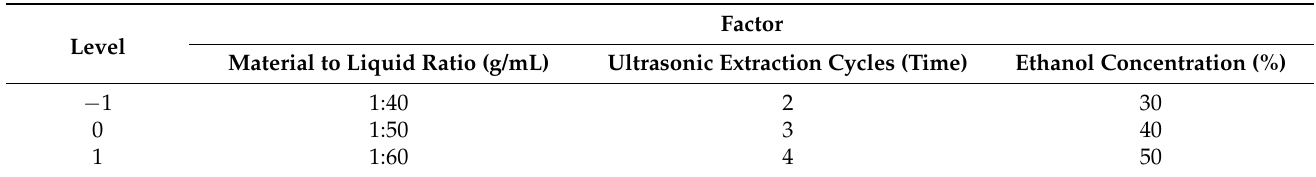
Table 6. Box-Behnken design factor